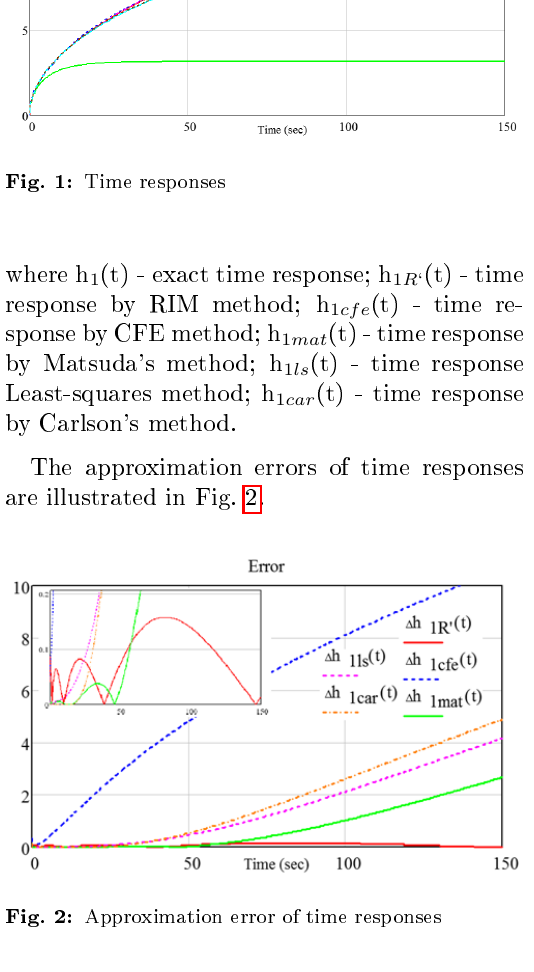
Fig. 2: Approximation error of time responses